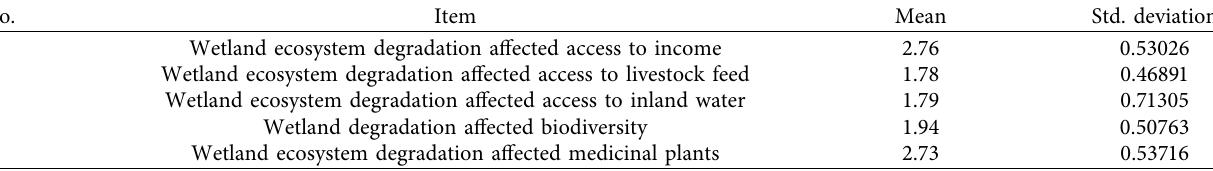
Table 4: Respondents’ view on communities’ attitude towards consequences of wetland ecosystems degradation. No. Item Mean Std. deviation